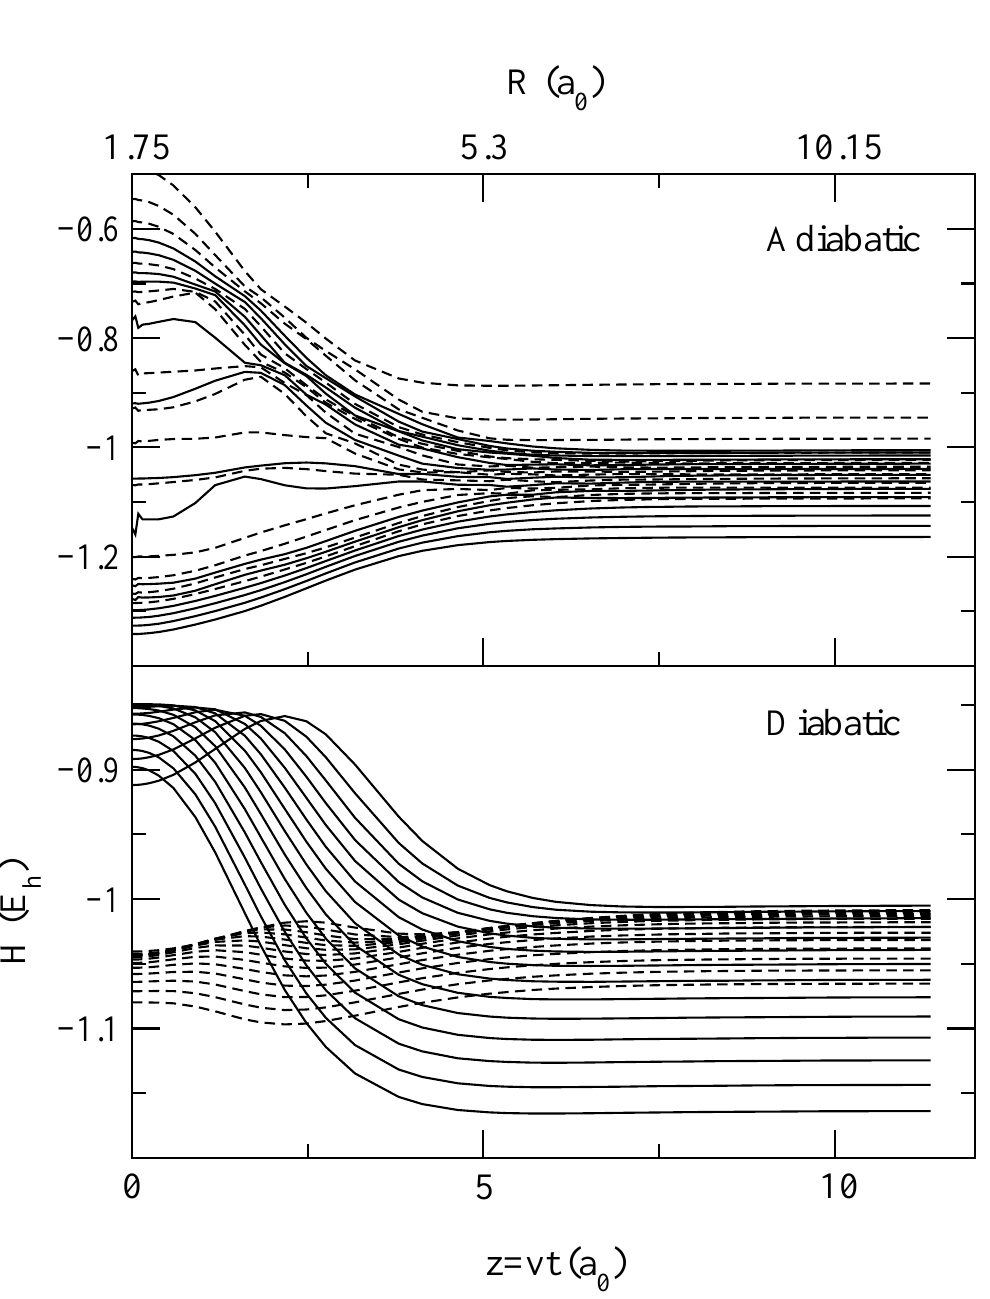
Figure 7: Energies of vibronic adiabatic (top panel) and diabatic (bottom panel) states as functions of the nuclear coordinate Z = vt for the trajectory I with b = 1 . 75 a elastic and H vibrational excitation channels and dashed lines to charge transfer 2